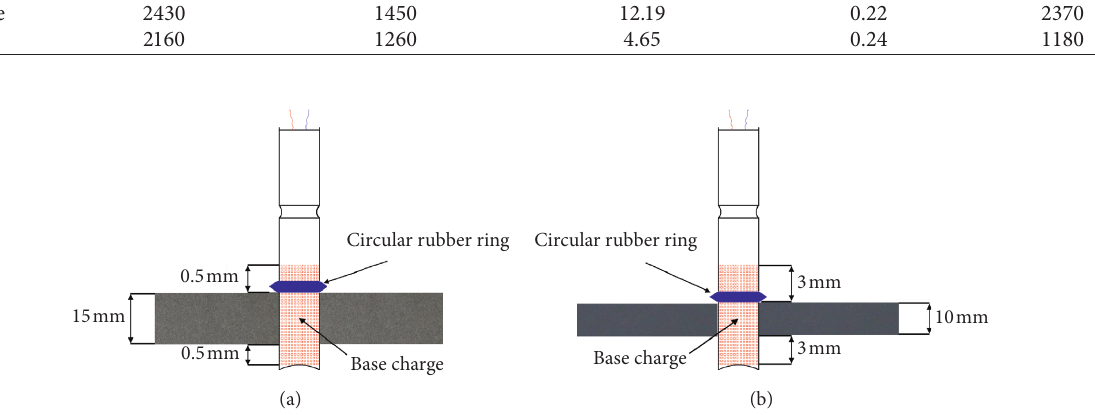
Figure 4: Sketch of the location of the detonator charge and the specimens. (a) Sandstone specimen. (b) PMMA specimen.